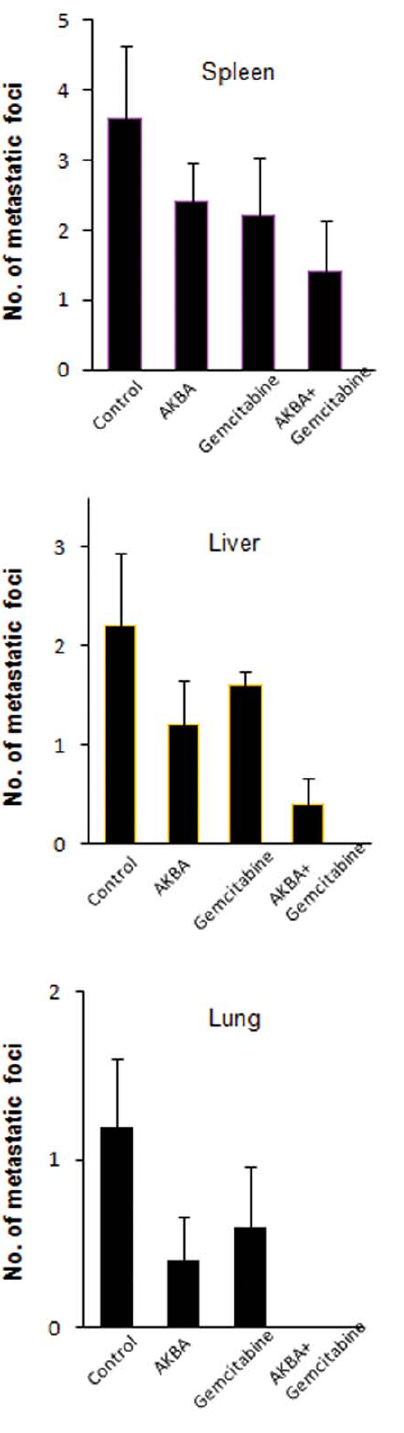
Figure 3. AKBA potentiates gemcitabine to inhibit distant organ metastasis in orthotopic PaCa nude mice. AKBA and gemcitabine combined inhibited metastases to the spleen, liver, and lungs. Mice were killed, and their abdomen was opened surgically, and then the number of metastasis foci in each organ was counted. Columns, mean; bars,